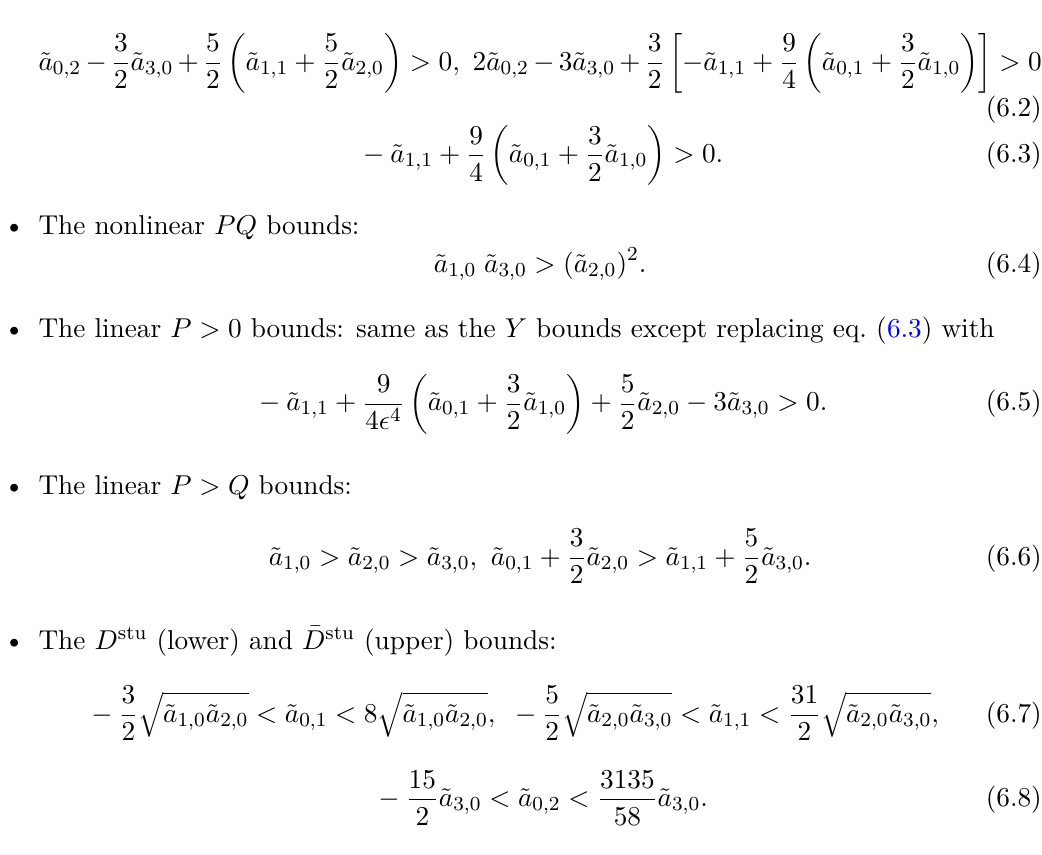
Figure 3 . Positivity bounds on c 4 , 4 /c 6 , 0 and c 5 , 2 /c 6 , 0 . The red (blue) lines are the D stu bounds with different choices of k . The enclosed region hexagon is the region allowed by the optimal positivity